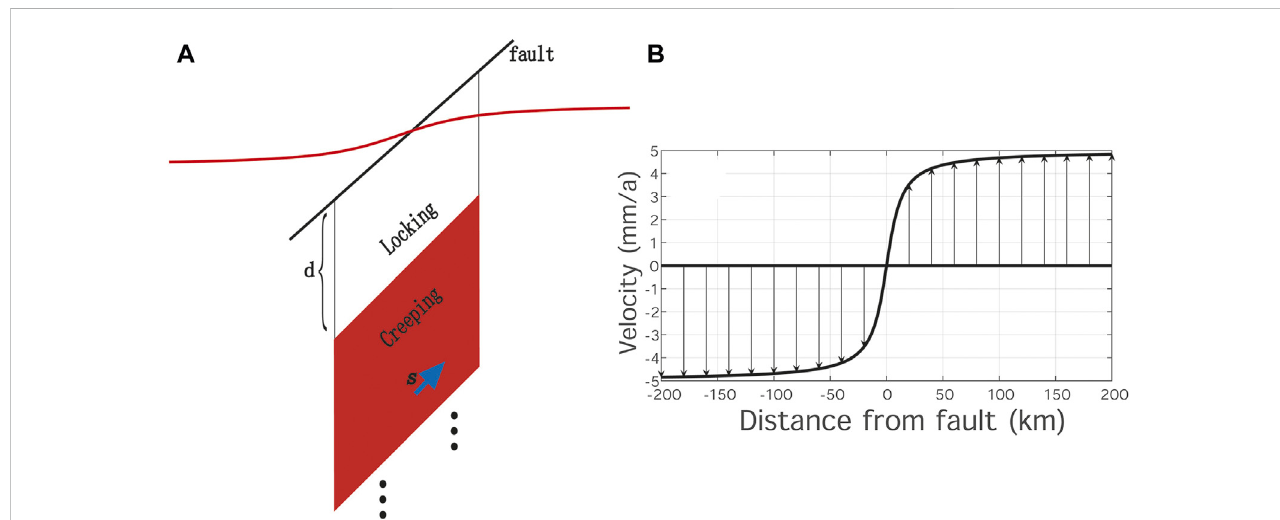
FIGURE 1 (A) Classic 2D strike-slip fault model and (B) produced surface deformation (redrawn according to Savage and Burford, 1973). A dextral strike-slip fault with a slip rate of 10 mm/a and a locking depth of 10 km was used as an